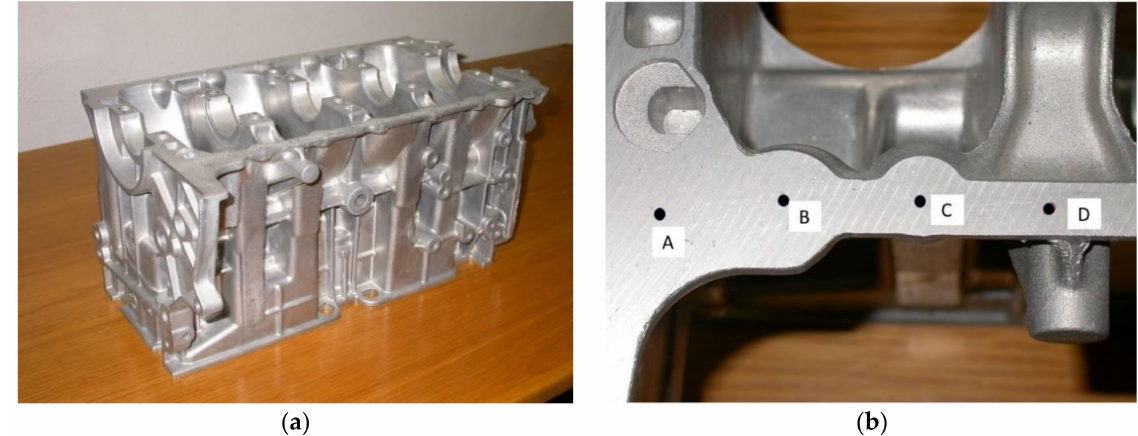
Figure 5. Carter in EN-AB46100 alloy ( a ). Several FIMEC tests have been performed in different positions (A, B, C, D) of this mechanical component to evaluate the local mechanical properties ( b